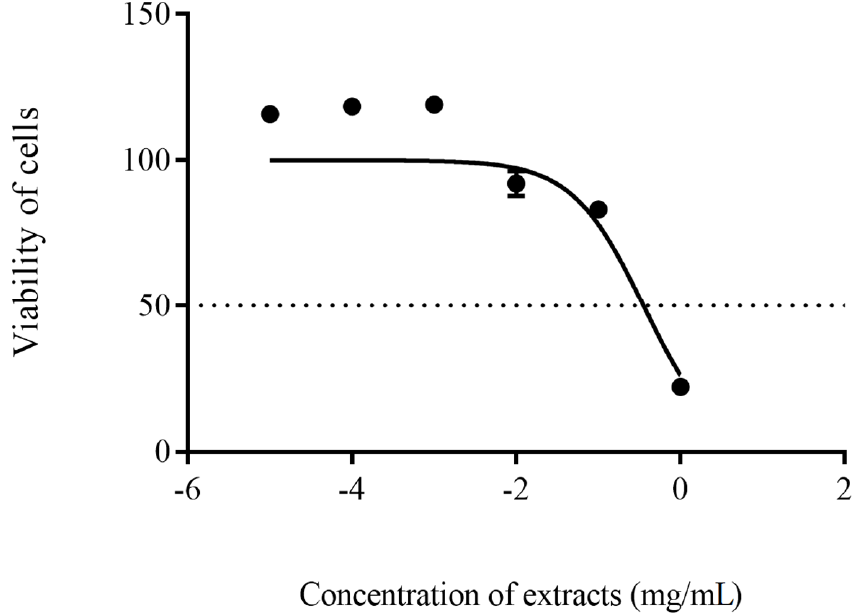
Figure 4. The cytotoxicity activity showed IC 50 values were at 0.35 ± 1.35 mg/mL on the cell viability of HEK 293. The experiment was carried out in triplicate.